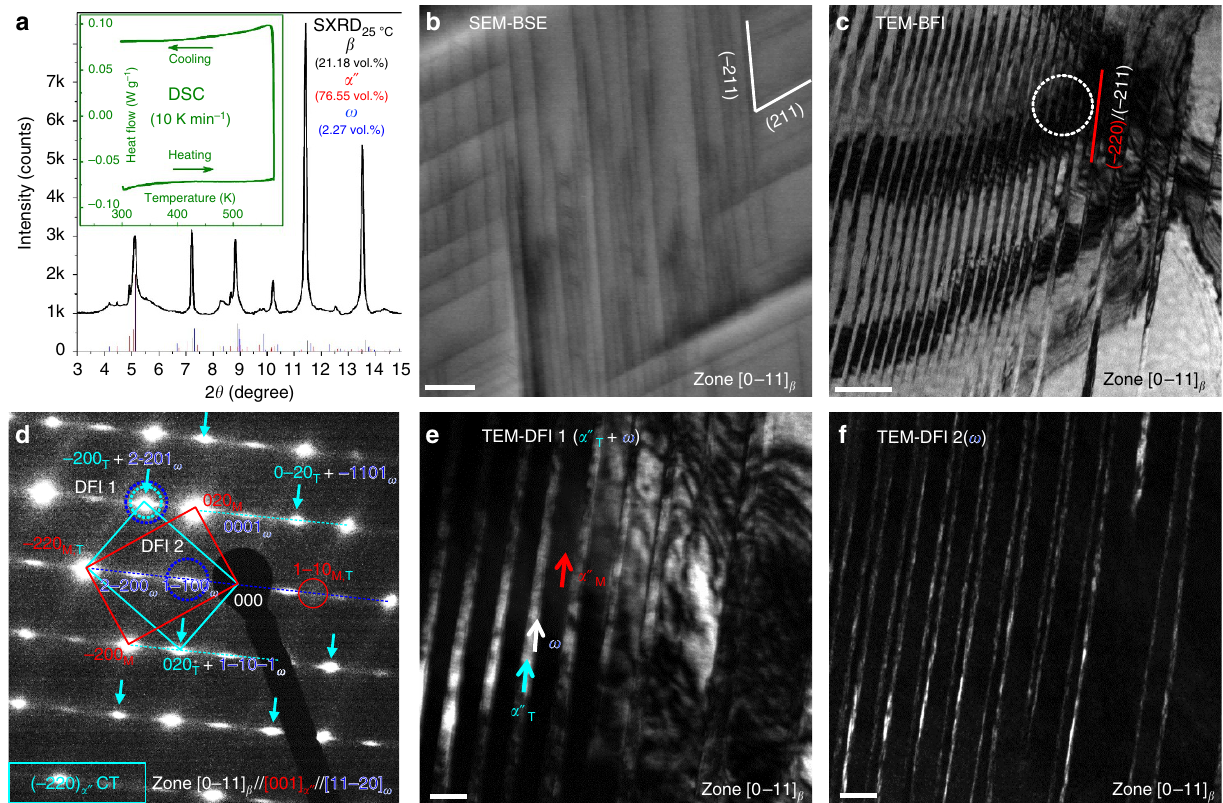
Figure 2 | Characterization of the complexion-mediated martensitic phase transformation. ( a ) One-dimensional SXRD pattern, with the DSC inset showing no clear thermal peaks. ( b ) SEM-BSE micrograph (scale bar, 2 m m) from a [0–11] b grain shows two sets of {220} a 00 CTs (bulk sample). ( c ) TEM–bright-field image (BFI) shows a set of CT (scale bar, 100nm). ( d ) Corresponding SADP from the area encircled in c . ( e , f ) DFIs (TEM–DFI 1 and 2) from the overlapping spot (cyan and blue dotted circles in d ) and from the a – o spot (blue circle in d ), which indicate that a – o planar complexion only locate along the CT boundaries (both scale bars, 20nm). CT, compound